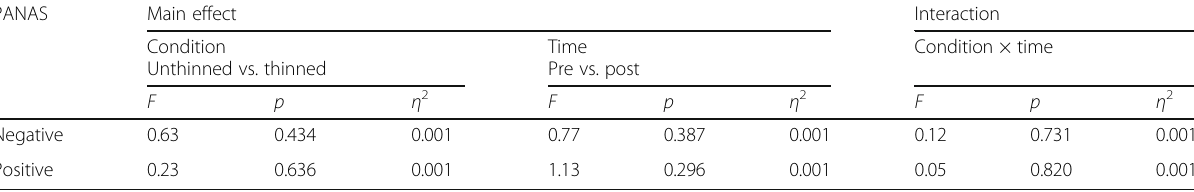
Table 9 Results of two-way repeated measures ANOVA for Positive and Negative Affect Schedule (emotion) PANAS